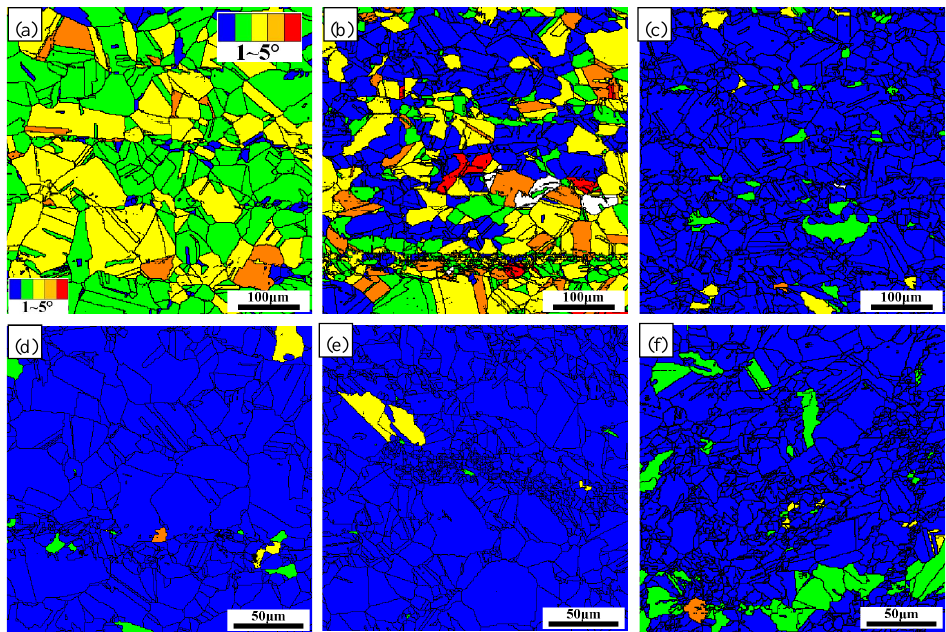
Figure 4. GOS colored maps of C276 superalloy annealed at 1050 °C for 30 min with different cold rolling reductions. ( a ) 5%, ( b ) 10%, ( c ) 15%, ( d ) 20%, ( e ) 30%, ( f ) 40%.